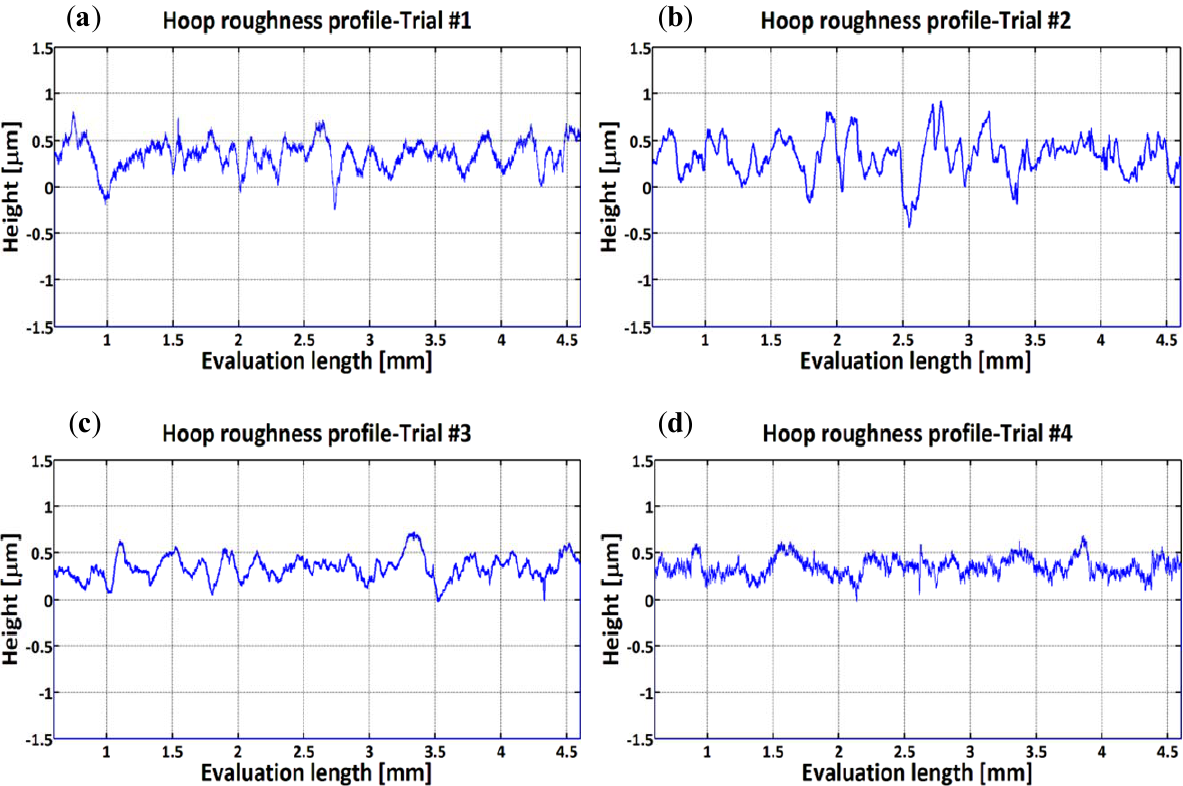
Figure 4. Surface profiles in hoop direction: ( a ) Trial #1; ( b ) Trial #2; ( c ) Trial #3 and